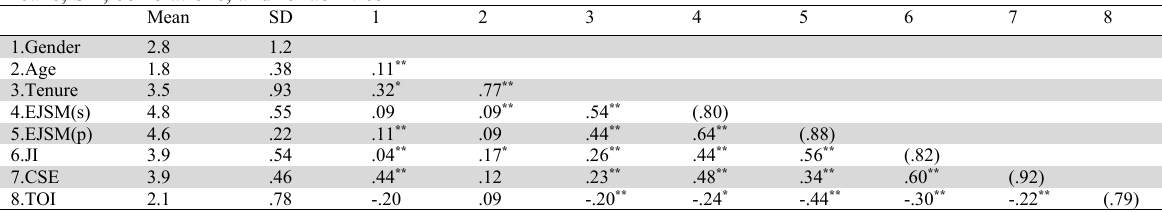
Means, SD, correlations, and